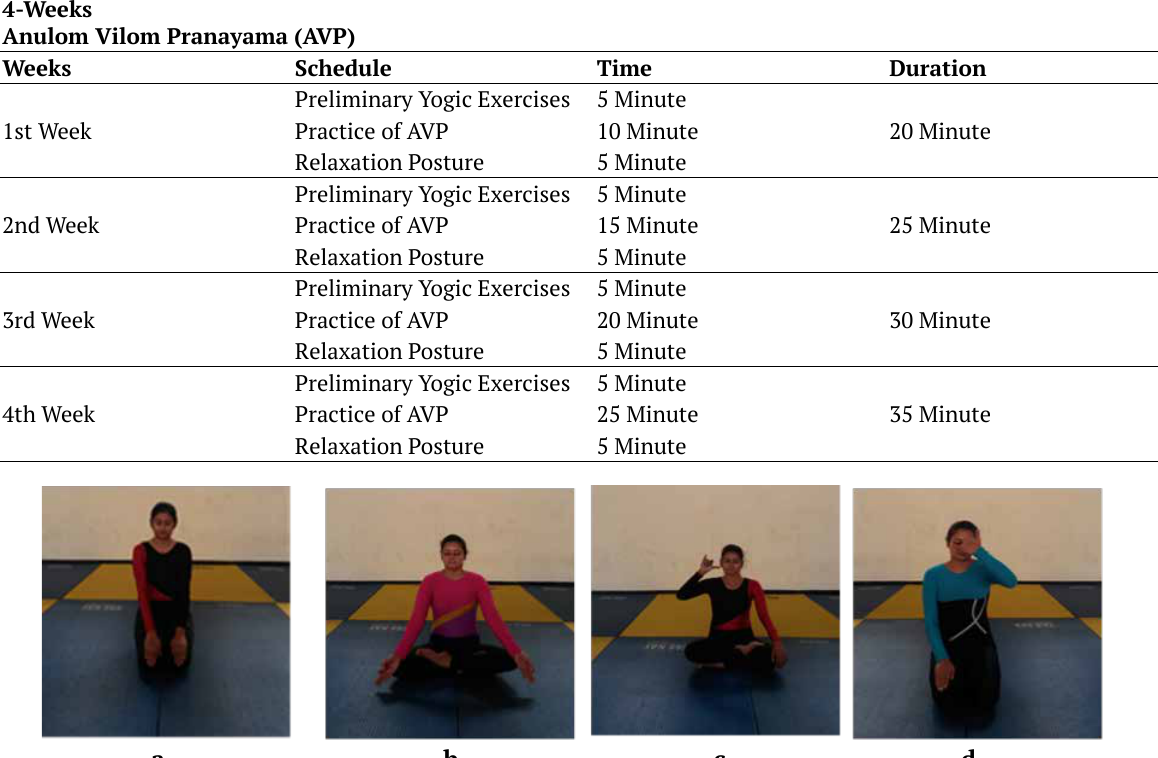
Table 2. Full protocol of 4-Weeks Anulom Vilom Pranayama Training.